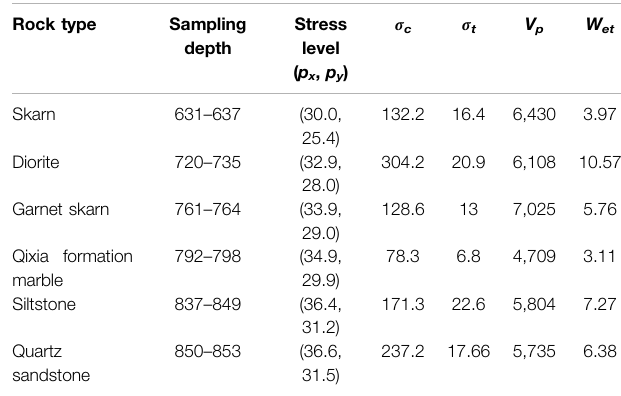
TABLE 8 | Rock sample test data of seven typical ore rocks from Donggua